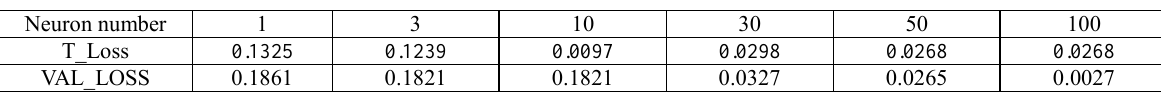
Table 2. Relationship between LSTM neurons and training